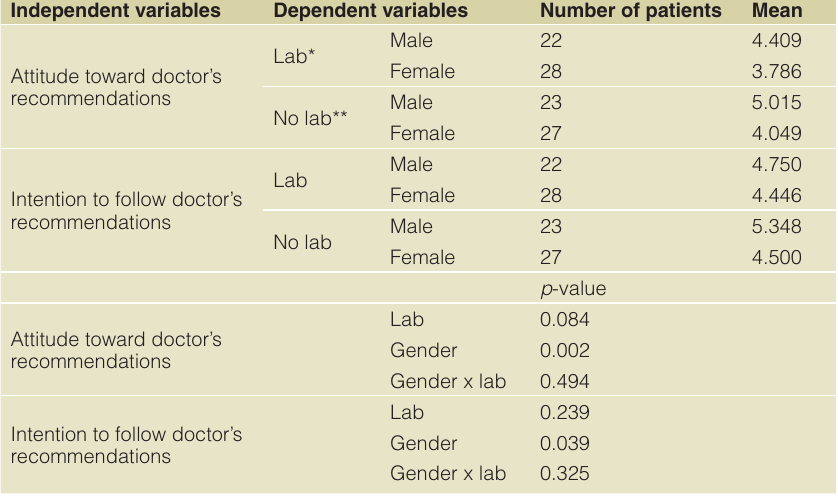
Table 5. Effects of gender: results of the two-way analysis of